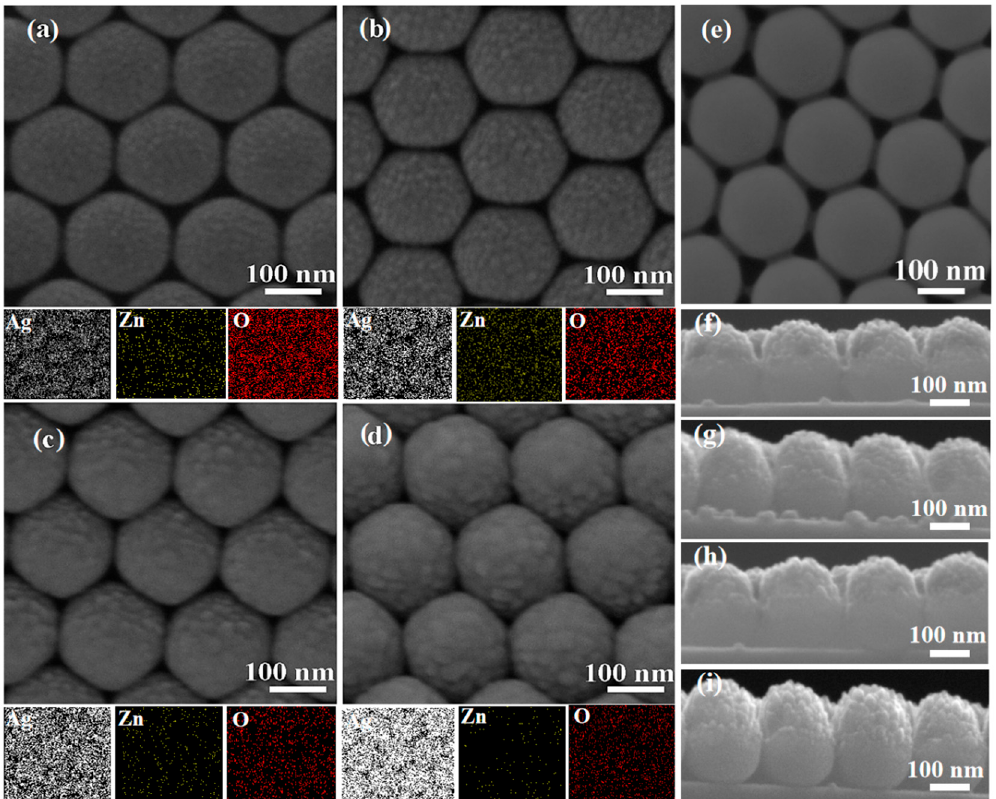
Figure 1. SEM images of the cosputtered Ag / ZnO systems. Ag and ZnO were cosputtered for 5 min with a 100 W ZnO sputtering power and ( a ) 10, ( b ) 20, ( c ) 30, and ( d ) 40 W Ag sputtering powers. ( e ) SEM image of a bare polystyrene (PS) array. ( f – i ) Cross-sectional images corresponding to ( a – d ), respectively.